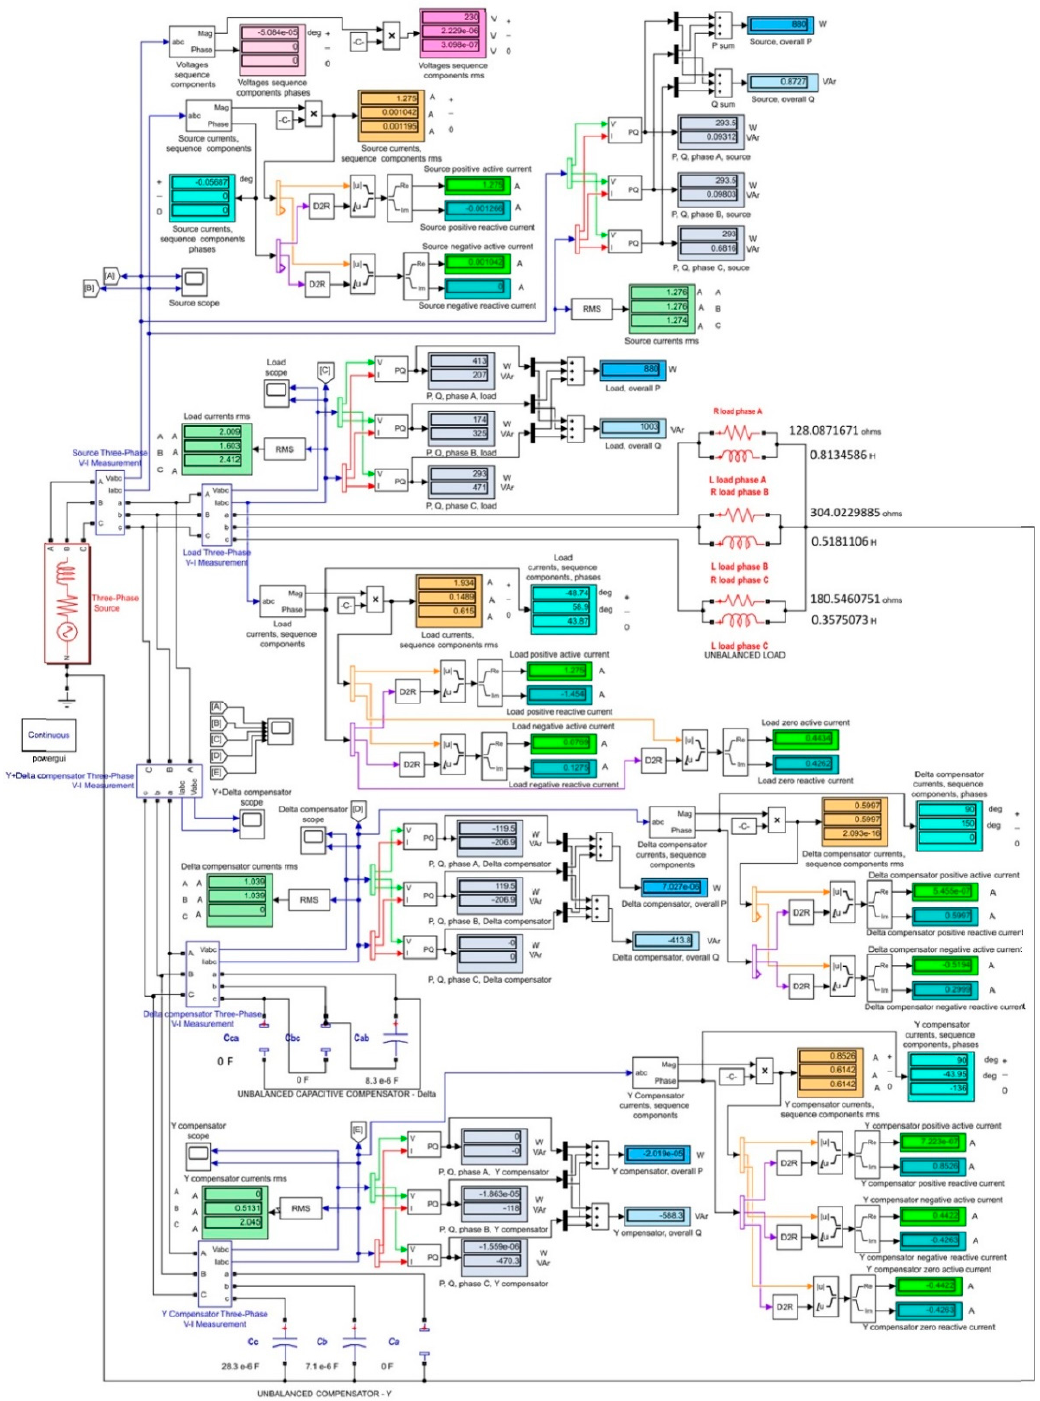
Figure 2. Diagram of the model studied with Matlab—Simulink.